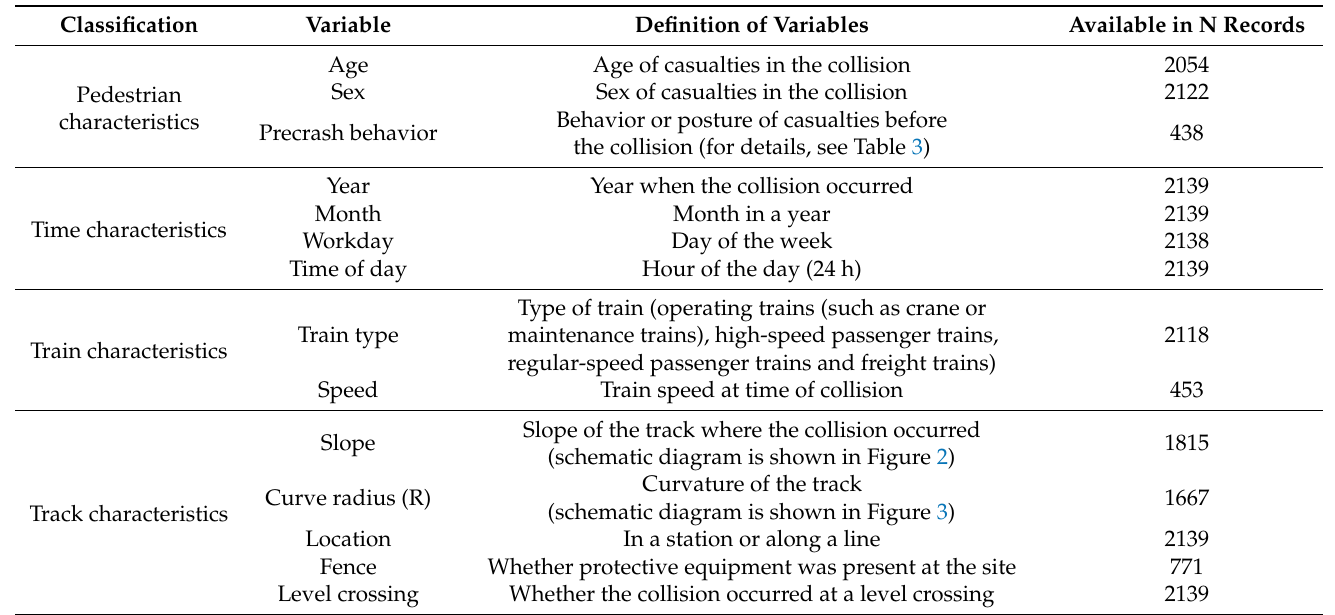
Table 2. Variable information divided into four